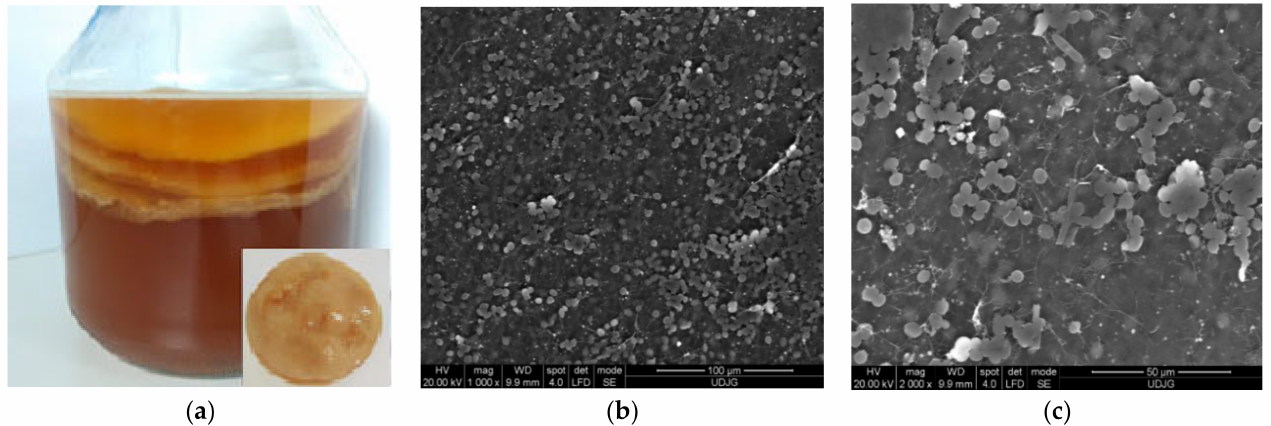
Figure 6. Kombucha biofilm ( a ); SEM images of kombucha biofilm ( b ) at × 1000 magnification and ( c ) at × 2000